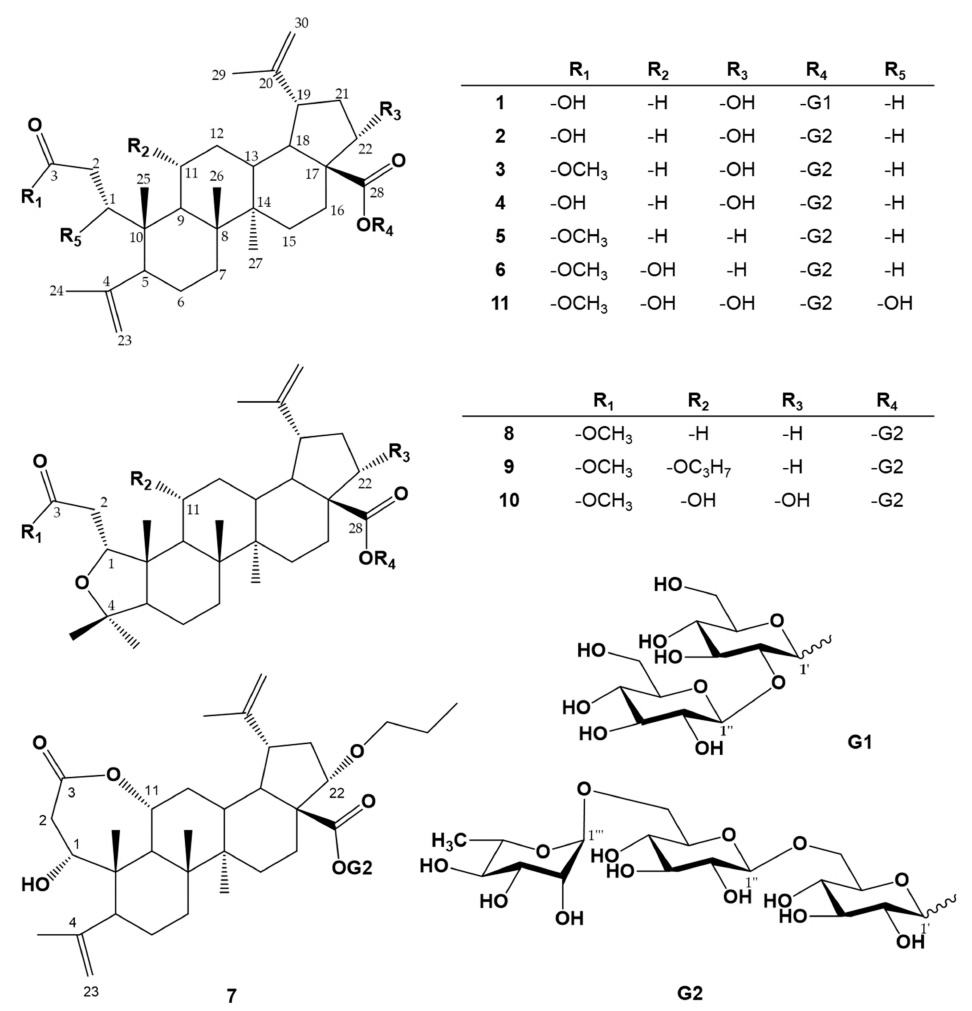
Figure 1. Chemical structures of compounds 1 – 11 from the fruits of Acanthopanax sessiliflorus. Compound 2 was obtained as a white, amorphous powder. The molecular formula was determined to be C 48 H 76 O 19 from the pseudomolecular ion peak [M − H] − at m/z 955.5059 (calculated for C 48 H 75 O 19 , 955.4902) in the negative HR-QTOF/MS. The 1 H NMR and 13 C NMR of compound 2 were similar to those of compound 1, except